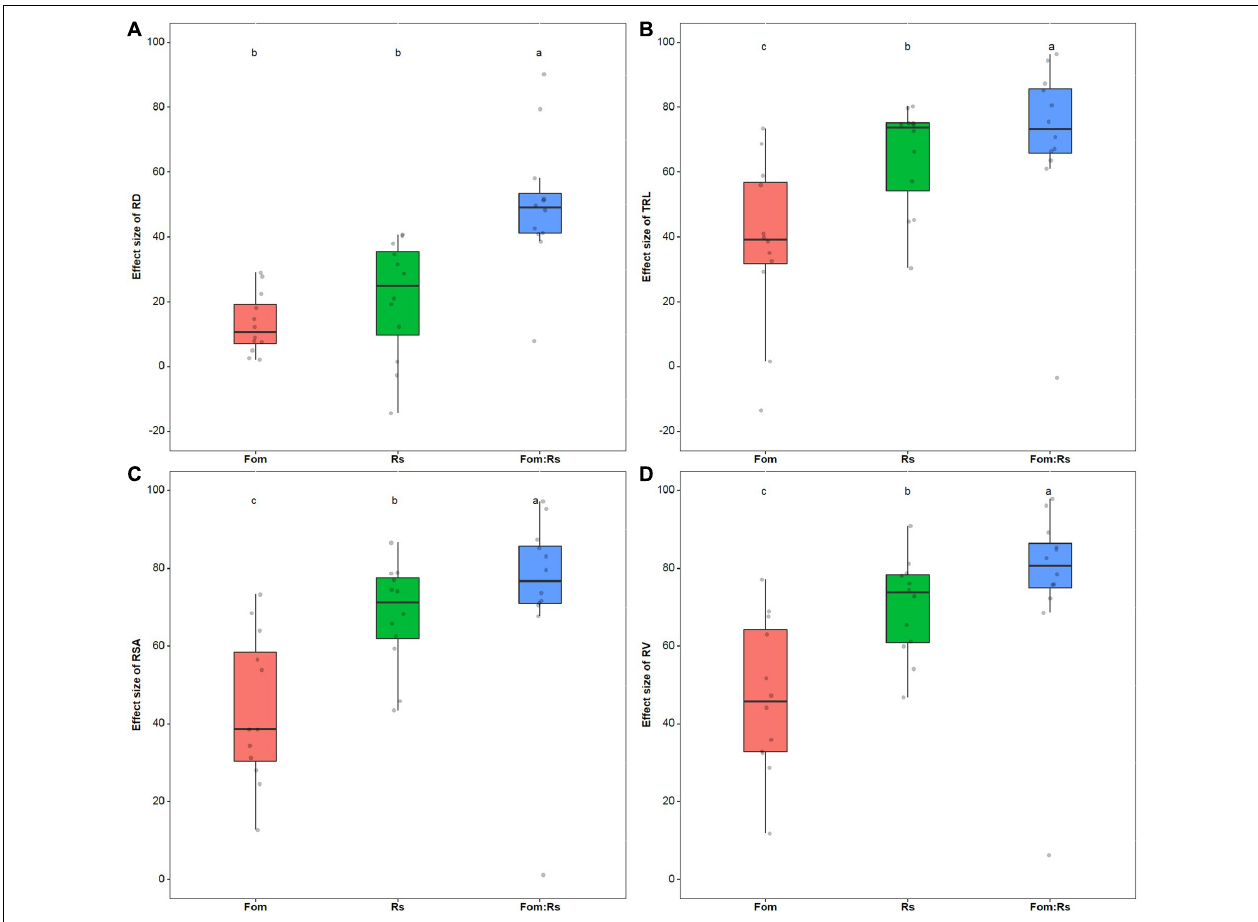
FIGURE 4 | Pathogen effects on root morphology among 12 alfalfa varieties single or co-inoculated with Fom and Rs. Effect sizes of (A) root diameter (RD), (B) total root length (TRL), (C) root surface area (RSA), and (D) root volume (RV). Fom, single inoculation with Fom; Rs, single inoculation with Rs; Fom:Rs, co-inoculation with Fom and Rs. Boxplots show the medians and 25th and 75th percentiles, with whiskers extending to 1.5 times of the interquartile range, and data presented beyond whiskers represent outliers. Different letters above the bars indicate significant differences ( p < 0.001) among treatments according to Fisher’s protected LSD test at p =